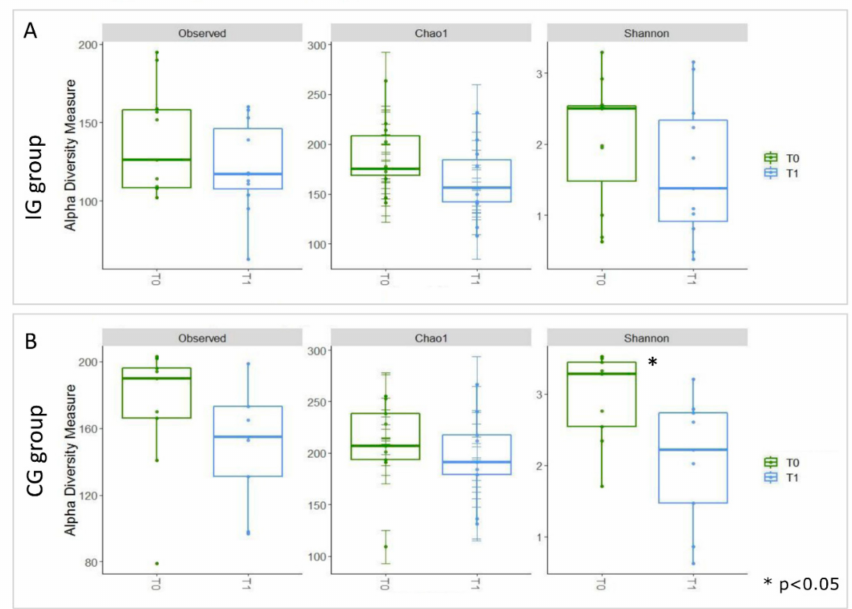
Figure 3. Boxplots representing α -diversity indices. The box plots represent the Observed, Chao1, and Shannon index-es for samples stratified for T 0 and T 1 in the IG ( A ) and CG ( B ) groups. The interquartile range is represented by the box, and the line in the box is the median. The whiskers indicate the largest and the lowest data points, respectively, while the dots symbolize outliers. The asterisk * indicates a p -value <